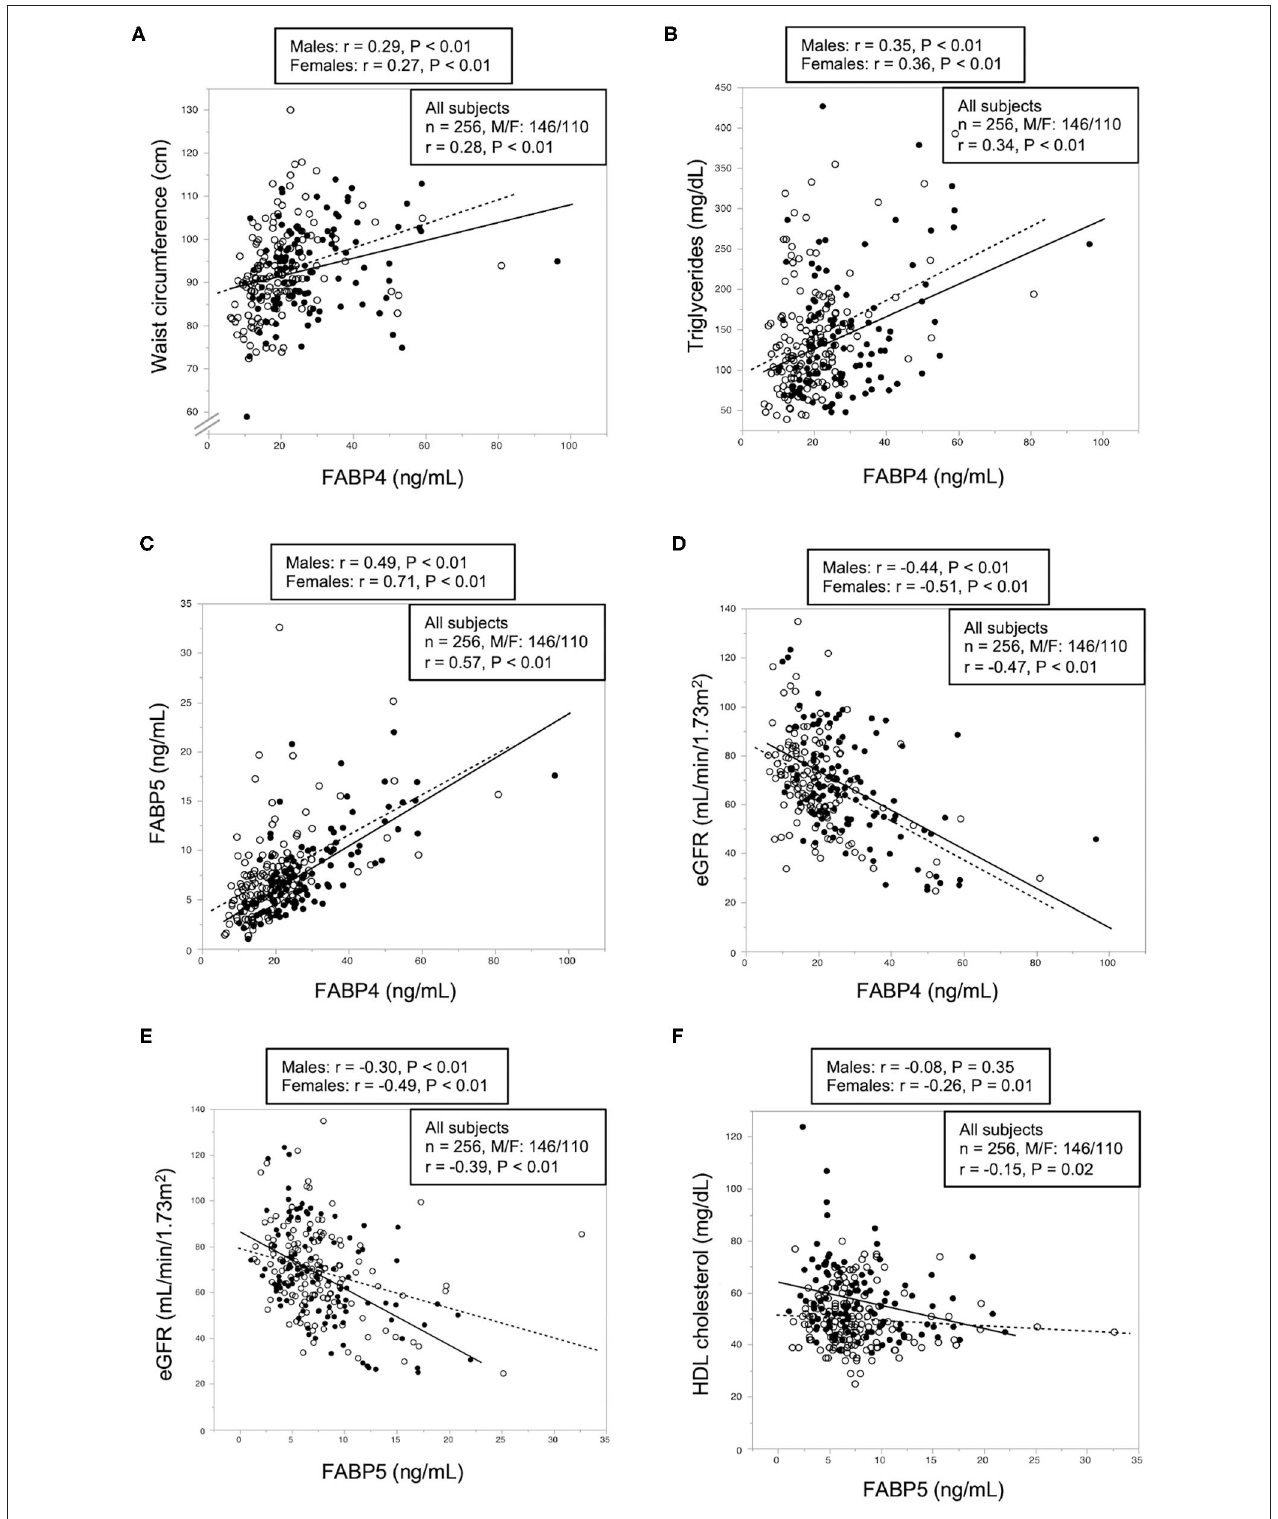
FIGURE 1 | Correlations of FABP4 and FABP5 levels with metabolic parameters. (A–D) Waist circumference (A) and levels of triglycerides (B) , fatty acid-binding protein 5 (FABP5) (C) and estimated glomerular filtration rate (eGFR) (D) were plotted against fatty acid-binding protein 4 (FABP4) level in each subject ( n = 256). (E,F) Levels of eGFR (E) and high-density lipoprotein (HDL) cholesterol level (F) were plotted against FABP5 level in each subject ( n = 256). Open circles and broken regression line: males ( n = 146), closed circles and solid regression line: females ( n = 110).